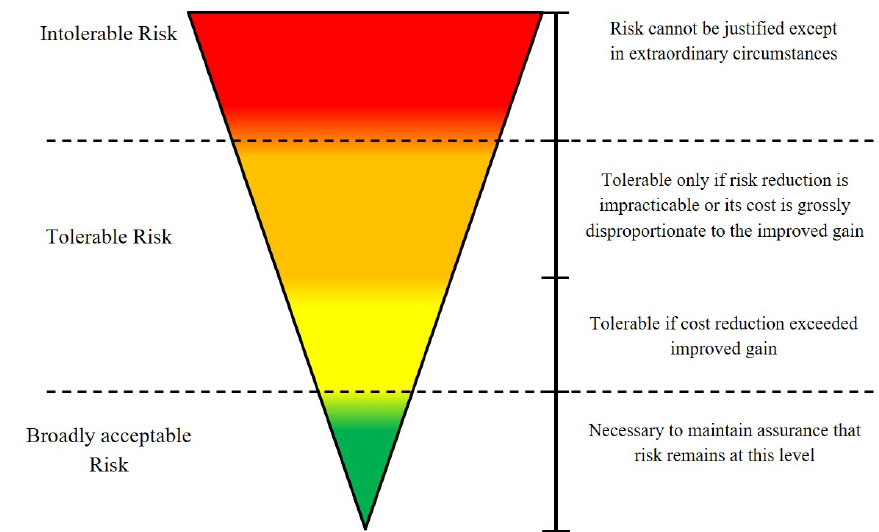
Figure 16. ALARP carrot diagram based on HSE